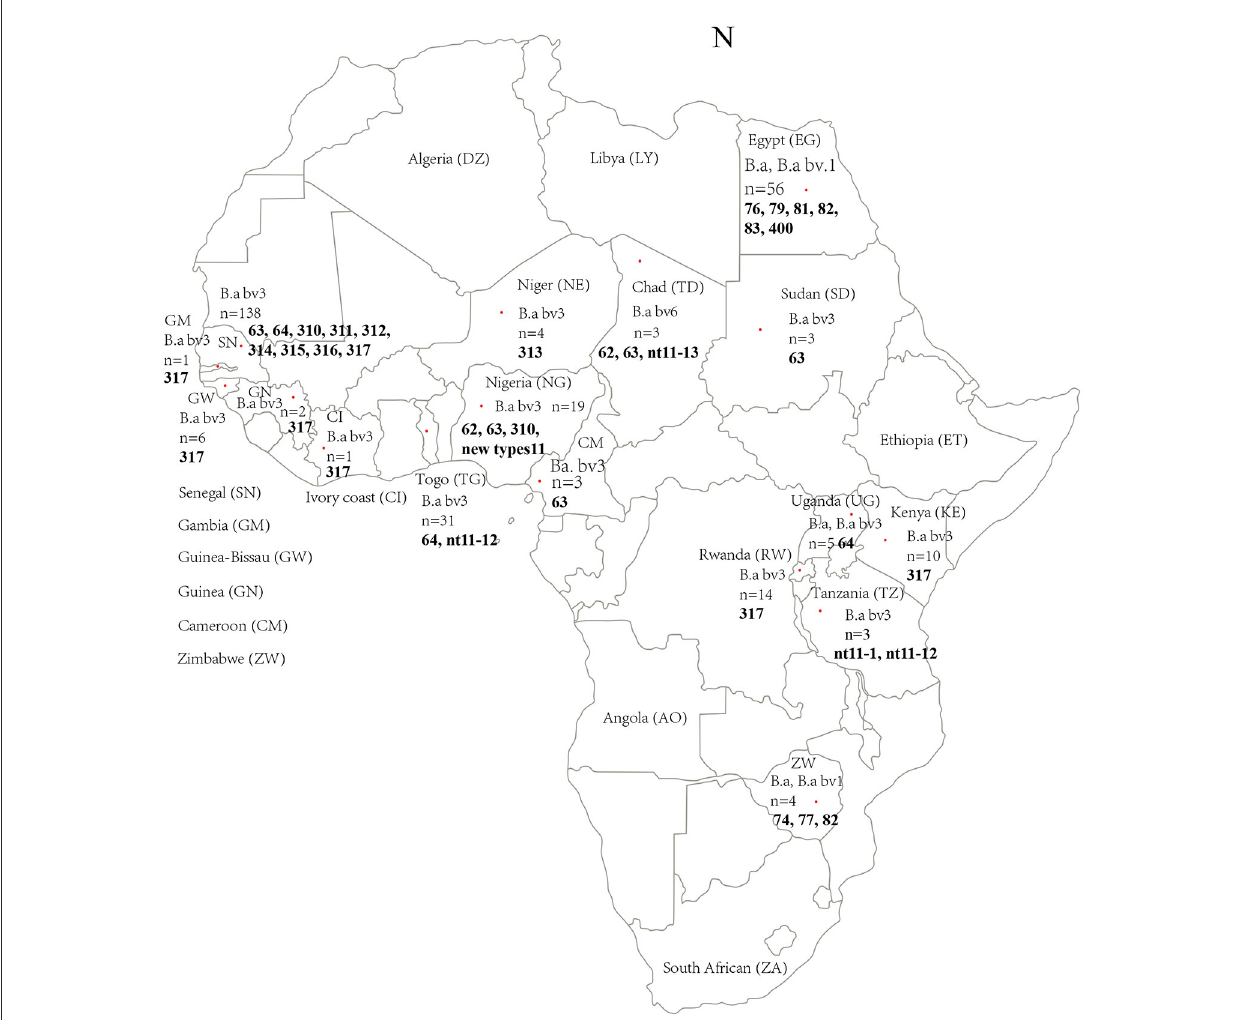
FIGURE1 Geographic and genotype distribution features of 309 B. abortus in the present study. Red dot indicates the location (country) of the strains collected in this study. The letter in brackets is the abbreviation of the national name in the figure; n , Number of strains collected; figures marked with the bold refer into the MLVA-11 genotypes of strains from the location. The map of Africa used in this study was obtained from Google Maps (https://www. google.com/maps).